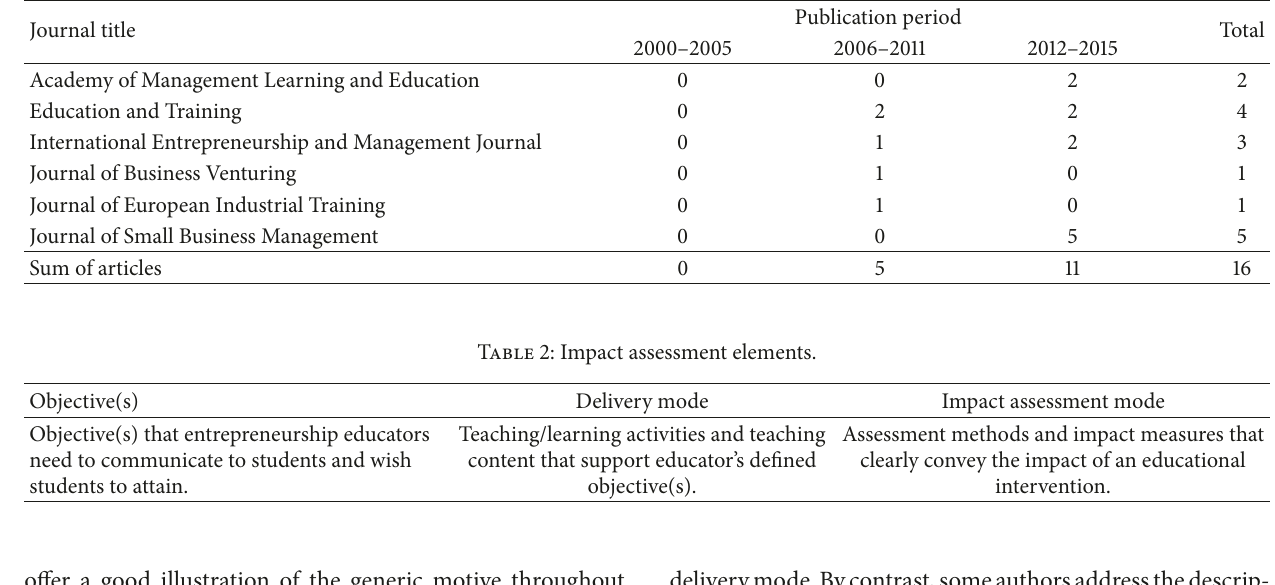
Table 1: Empirical impact studies published in each journal 2000–2015.